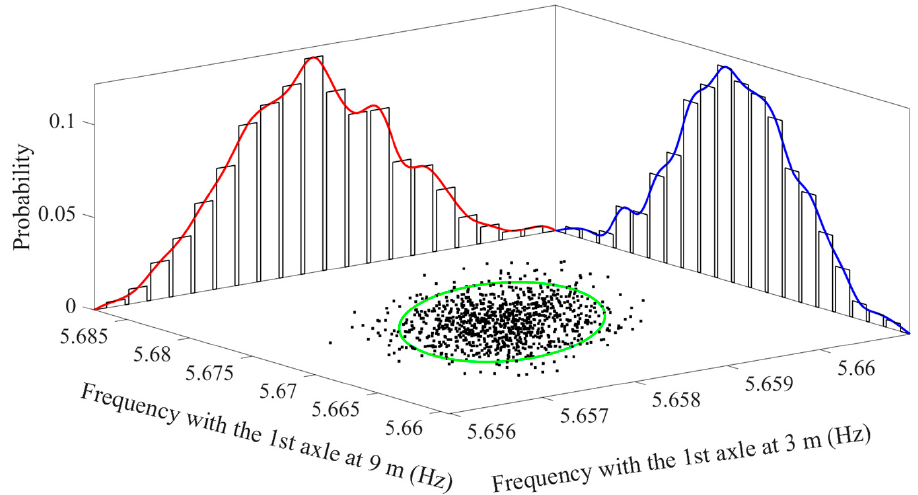
Figure 5. Bivariate distribution of bridge eigenfrequencies associated with the 1st axle located at 3 and at 9 m.